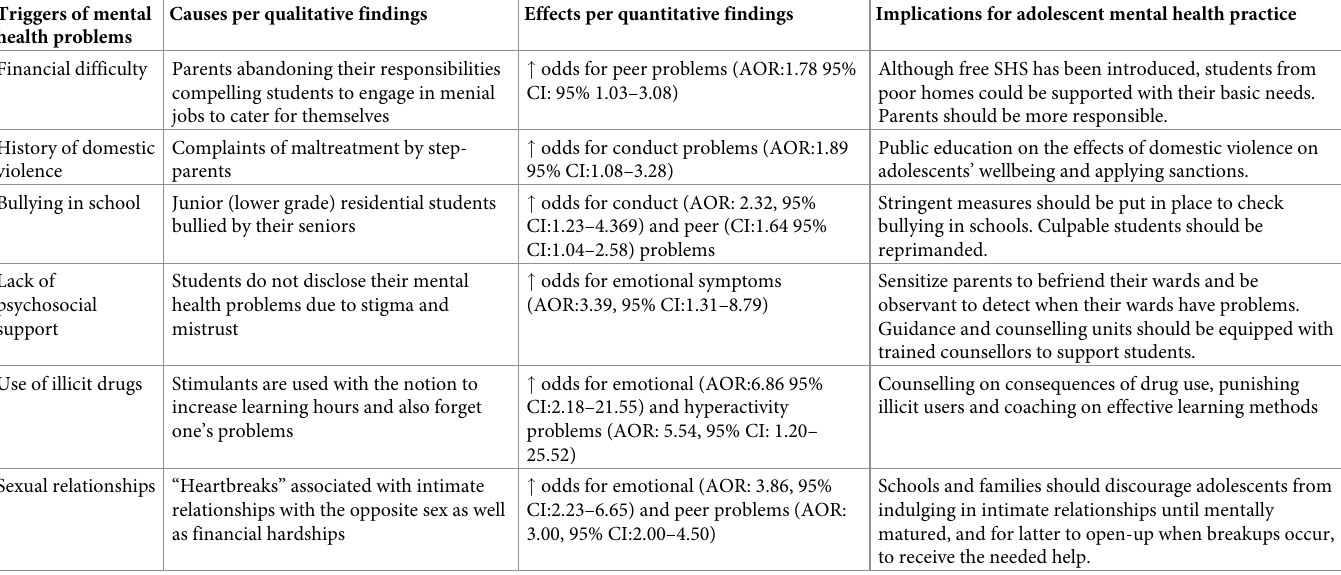
Table 4. Joint display of key quantitative and qualitative findings and implications for adolescents’ mental health care. Triggers of mental Causes per qualitative findings Effects per quantitative health problems